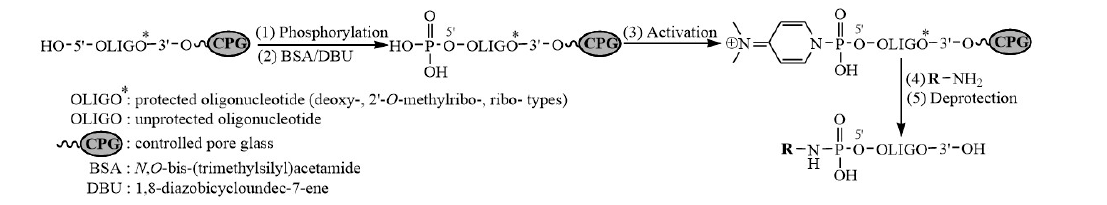
Figure 1. The common scheme for oligonucleotide solid-phase 5 ′ -functionalization. R–NH 2 struc- tures: see Supplementary Table S1.